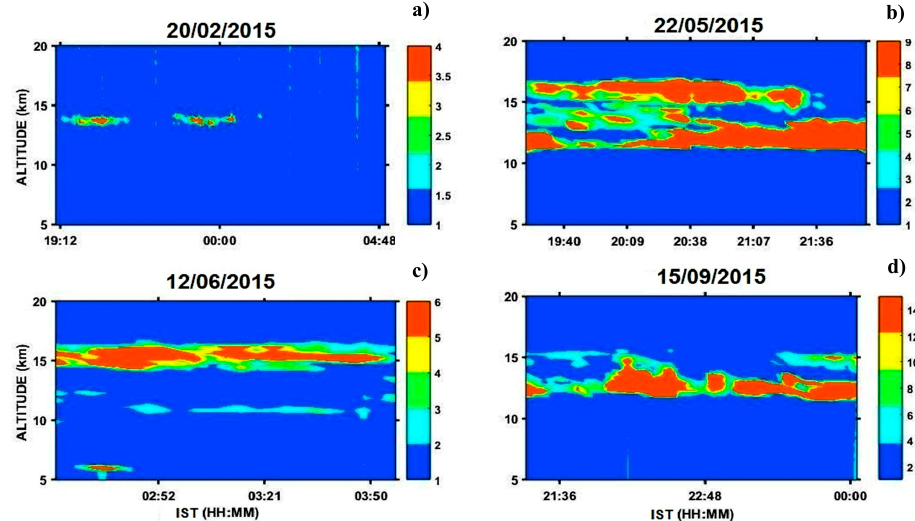
Figure 4. Height-Time evolution of lidar scattering ratio profiles of cirrus clouds for the prominent seasons winter, pre-monsoon, monsoon, and post-monsoon seasons, observed on ( a ) 29 January 2014; ( b ) 22 April 2014; ( c ) 17 August 2014; and ( d ) 14 November 2014.